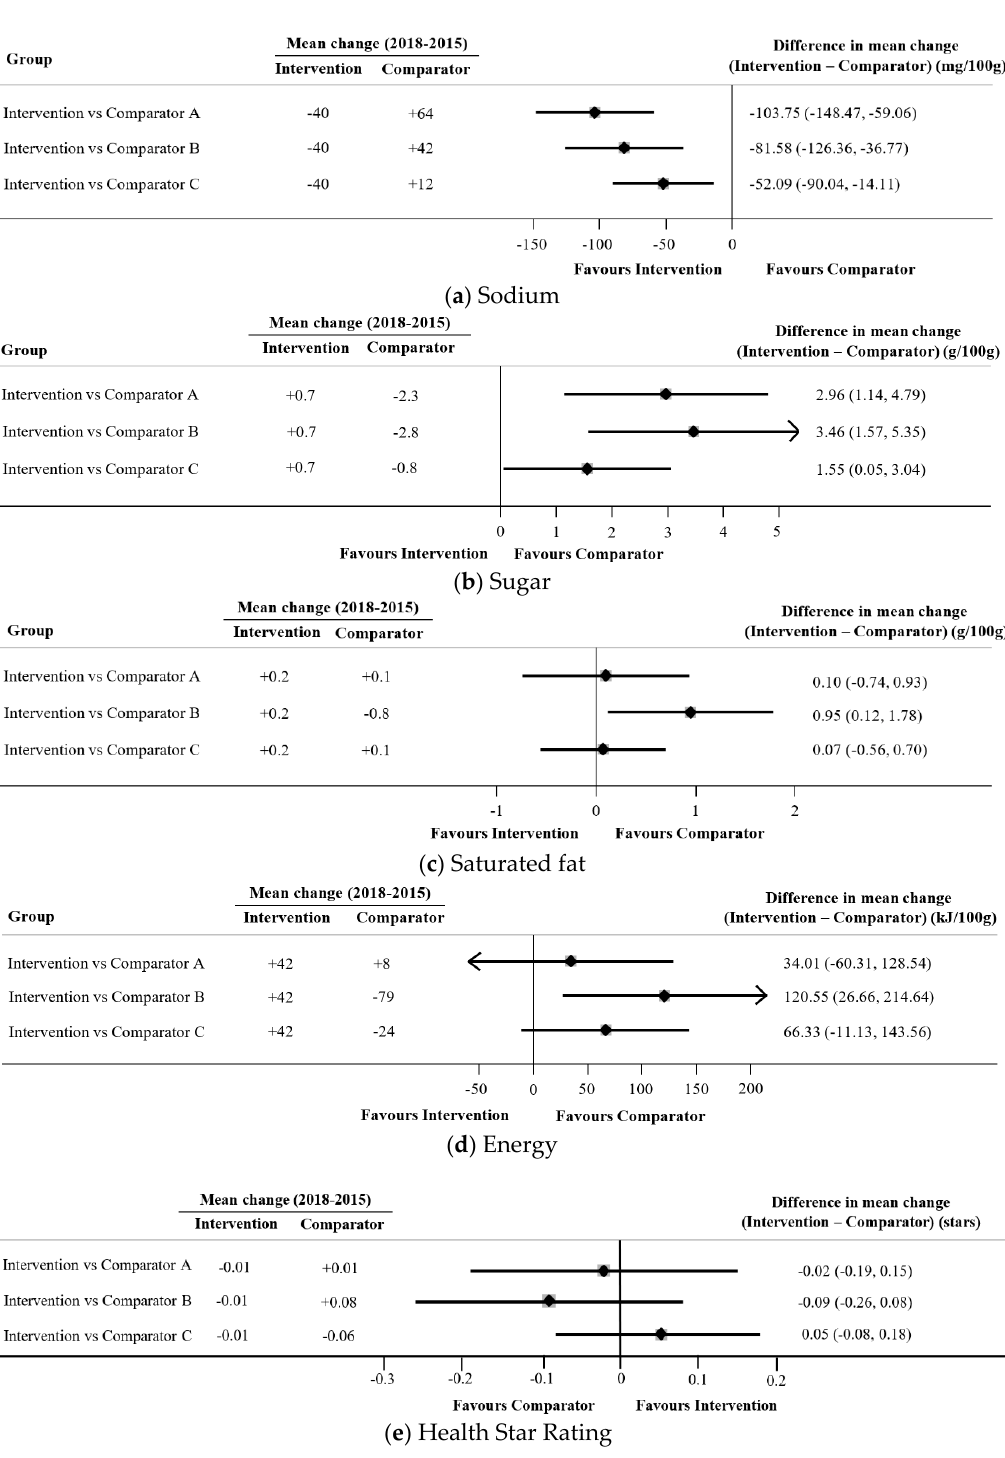
Figure 2. Differences in mean change in nutrient content (sodium (mg/100 g), sugar (g/100 g), Figure 2. Di ff erences in mean change in nutrient content (sodium (mg / 100 g), sugar (g / 100 g), saturated fat (g/100 g) and energy (kJ/100 g)) and Health Star Rating (stars) between 2015 and 2018 saturated fat (g / 100 g) and energy (kJ / 100 g)) and Health Star Rating (stars) between 2015 and